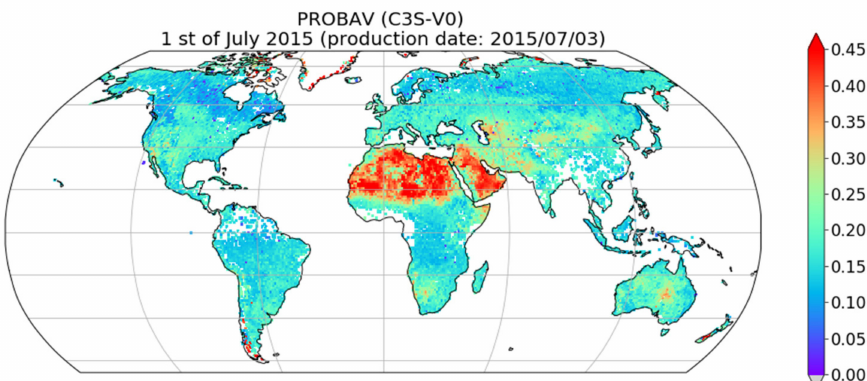
Figure 10. Total shortwave directional-hemispherical albedo (BB-DH) for 1 July 2015 based on PROBA-V